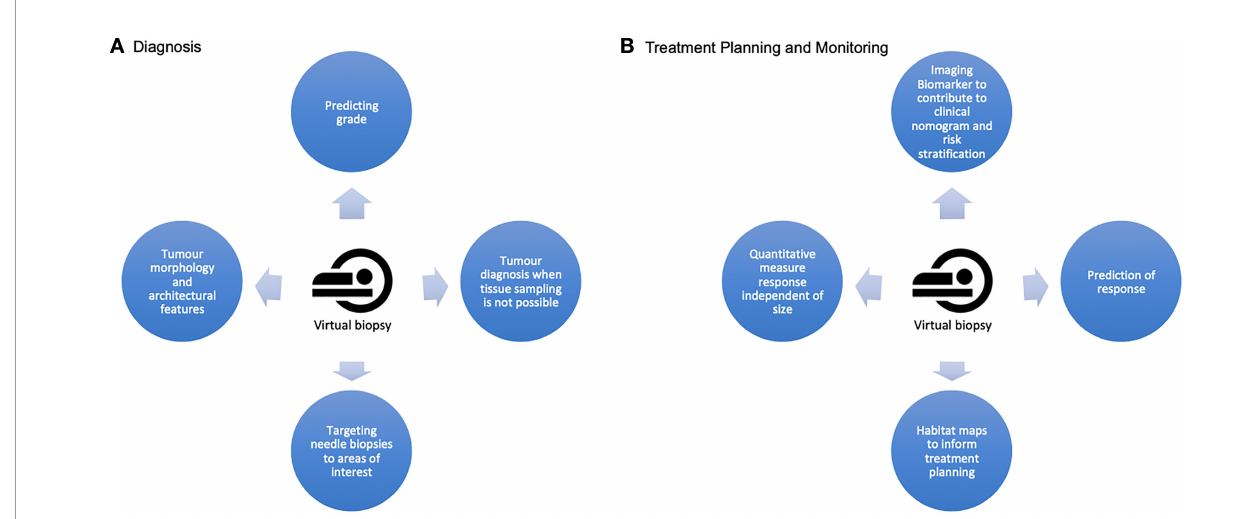
FIGURE 4 | A summary of the potential applications of a virtual biopsy at the two crucial stages of a sarcoma patient's cane pathway (A) At diagnosis, a virtual biopsy can offer quantitative imaging biomarkers to improve accuracy of grading, complimentary architectural information about the lesion and information about diagnosis and grade when needle biopsy is not possible. It can also guide precision needle biopsy. (B) For treatment planning and monitoring, virtual biopsy offers the opportunities for improved patient risk strati fi cation and prediction of therapeutic response. It can provide information assimilated in habitat maps to capture global and spatial heterogeneity for improved treatment planning, and provides the potential for serial quantitative, non invasive measures of response which are independent of tumour